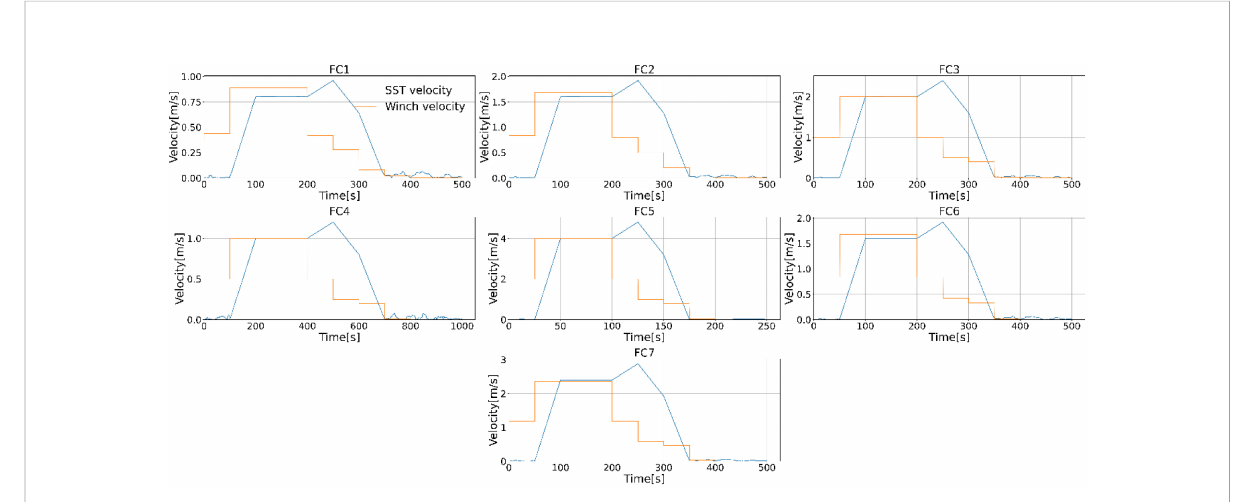
FIGURE 6 The SST velocity and cable hoisting velocity in each load case for validating the fl owline connecting process.